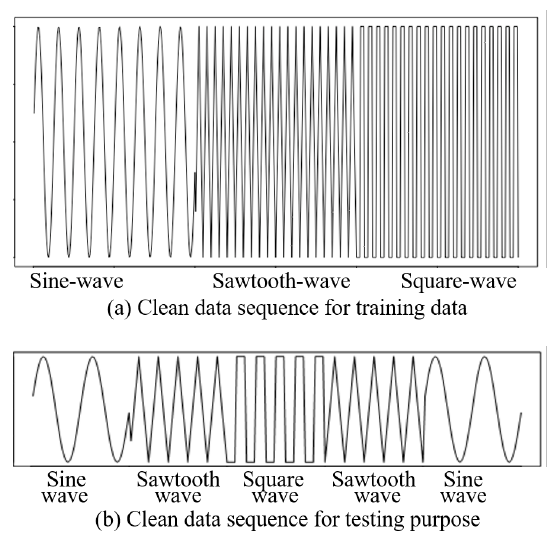
Figure 2. Time-series data having three different signals: sine wave, sawtooth wave, and square wave; ( a ) clean data sequence for training data; ( b ) clean data sequence for testing purposes.